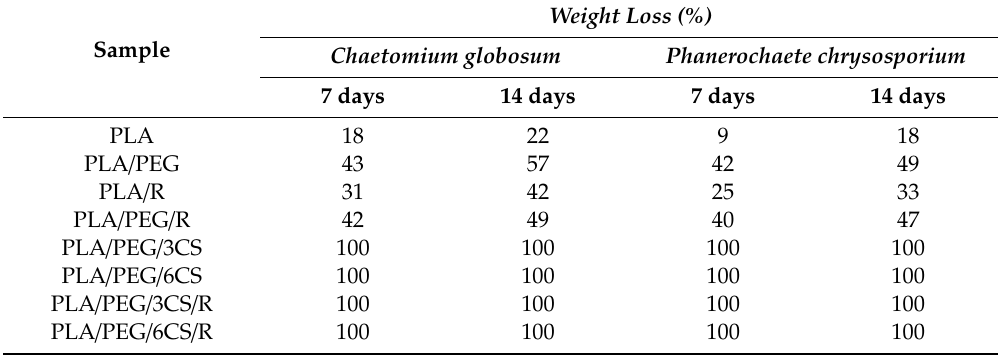
Table 2. The percent of weight loss of PLA-based samples subjected to fungal cultures. Weight Loss (%) Sample Chaetomium